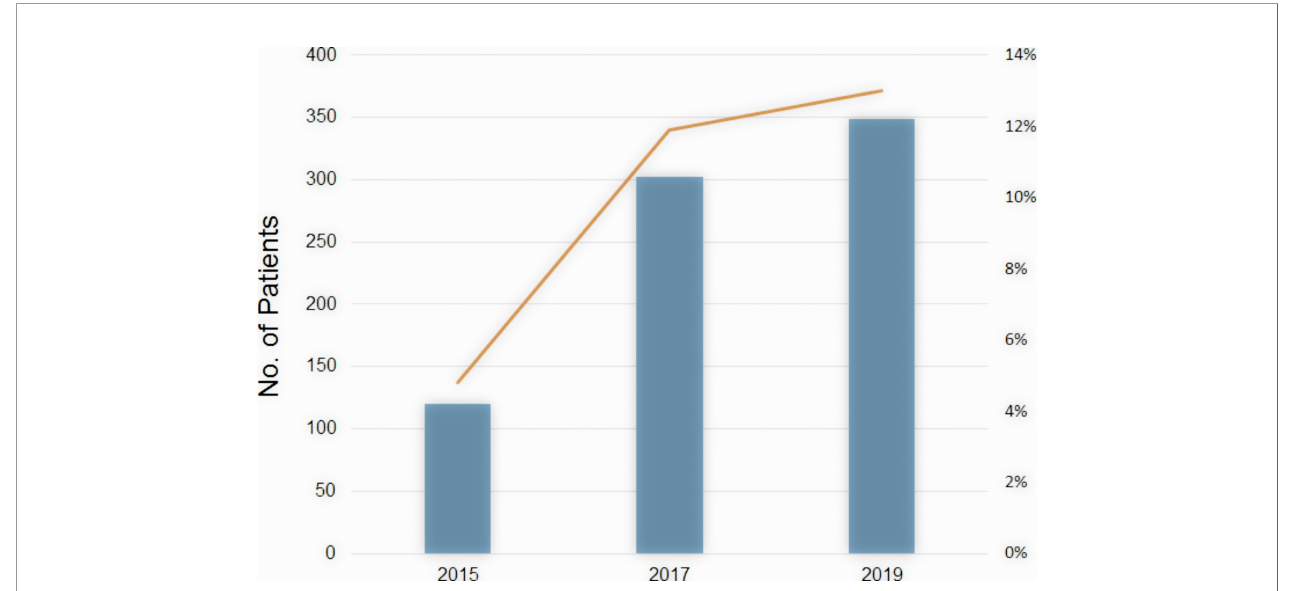
FIGURE 5 | The number of patients undergoing HBT in Japan (bar) and the ratio of HBT in brachytherapy of cervical cancer (line) by